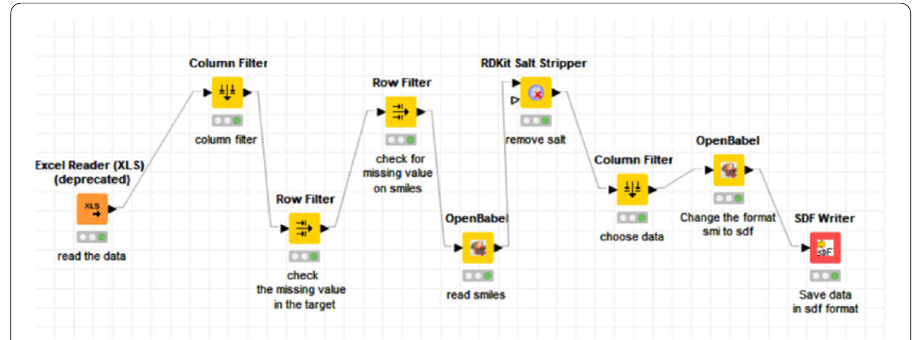
Fig. 2 KNIME workflow for several data acquisition